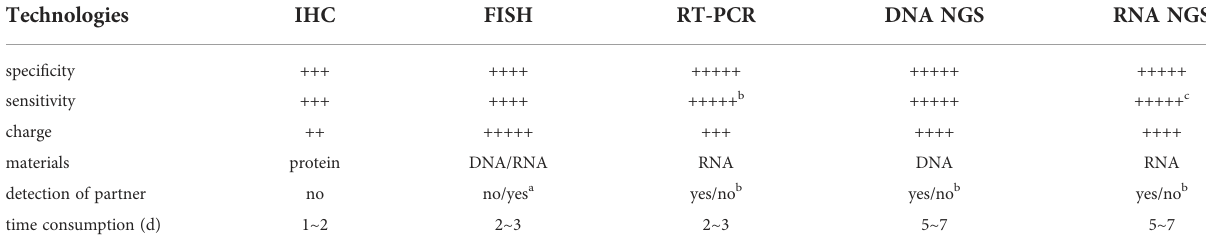
TABLE 2 Comparison of several detection technologies.